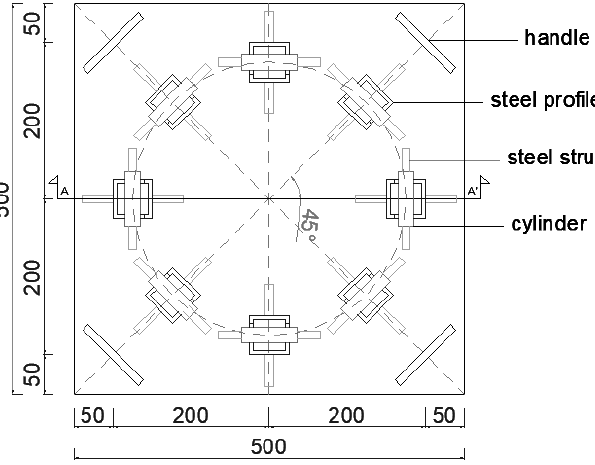
Figure 6. Experimental design of the circular supporting pattern (dimensions in mm).